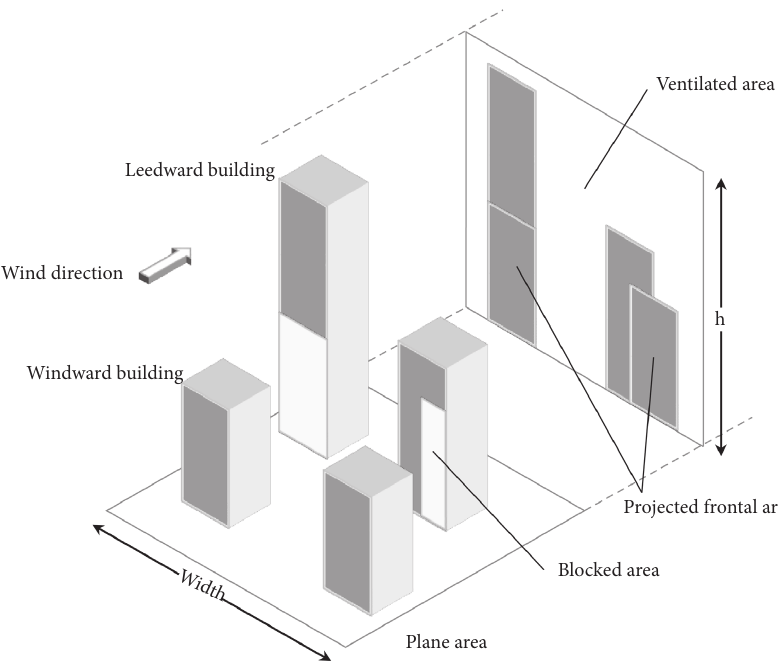
Figure 2: Diagram of the frontal area